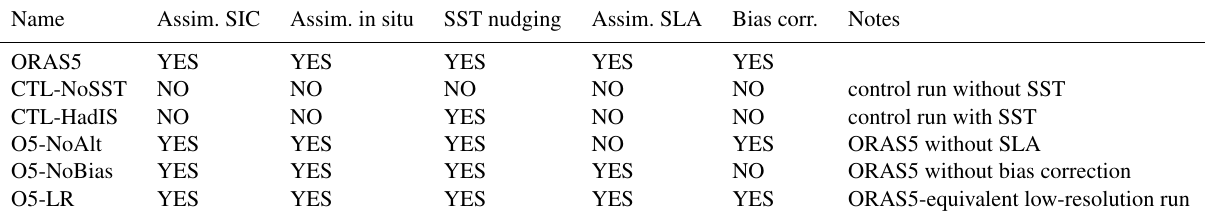
Table 5. Summary of ORAS5 sensitivity experiments.